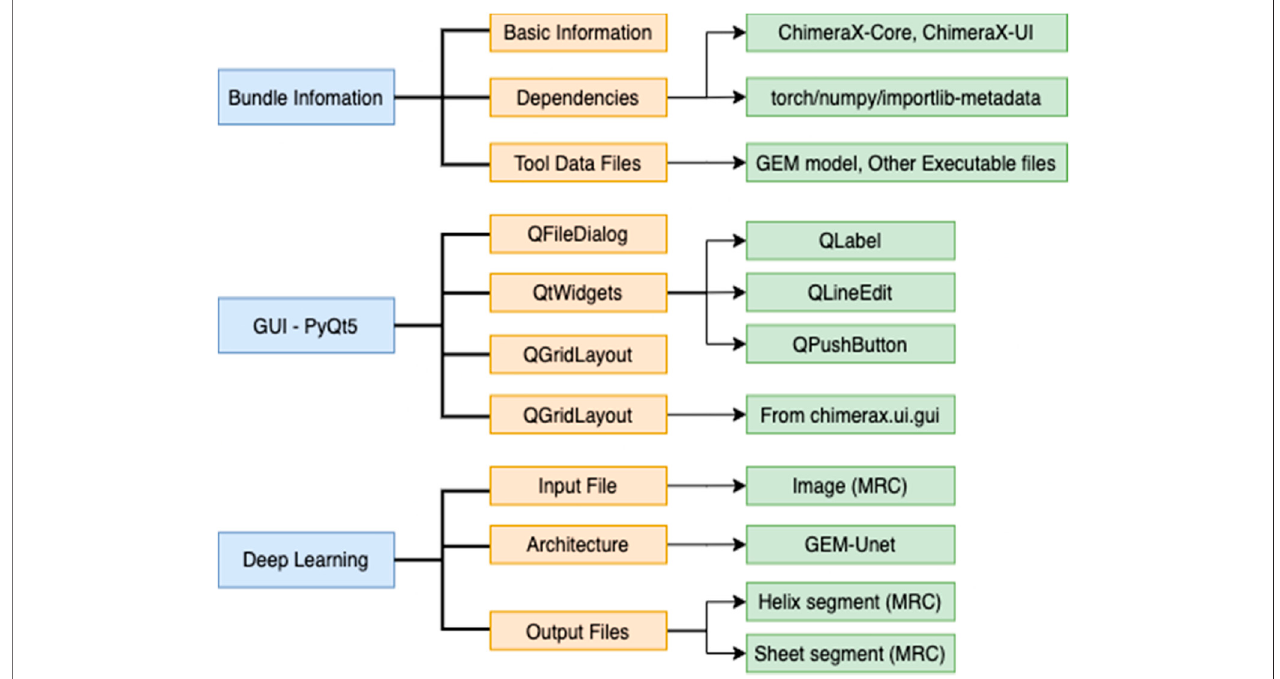
FIGURE 4 | DeepSSETracer 0.1 bundle